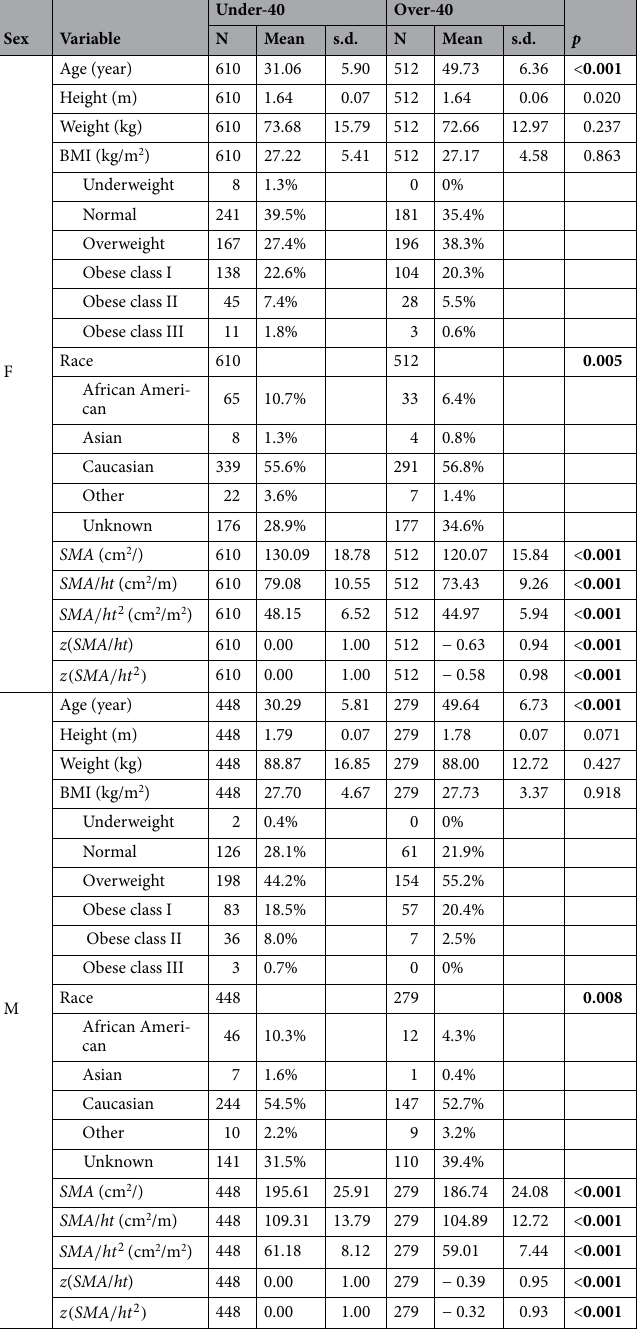
Table 1. Sex- and cohort-specific demographics and skeletal muscle measures. p-values less than 0.01 shown in